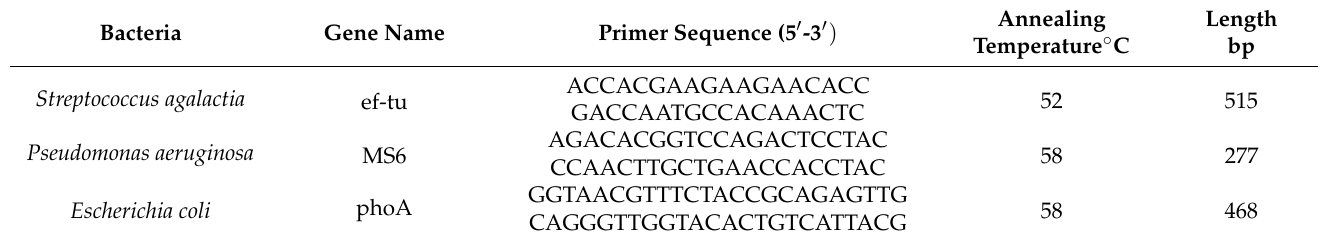
Table 1. The primer sequence of the genes and the length of the